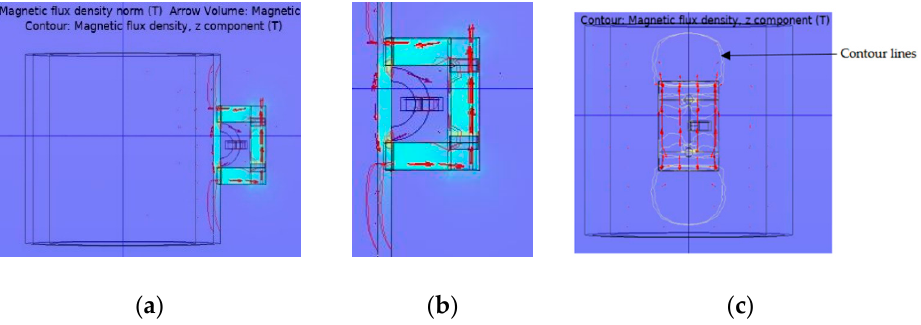
Figure 3. The magnetic flux pattern along the pipe in the z direction. ( a ) Magnetic flux lines from the ferrite core with the coil. ( b ) Zoom out picture of flux lines from the magnet and coil sensor. ( c ) Top view of the c ontour plot showing the magnetic flux flow.